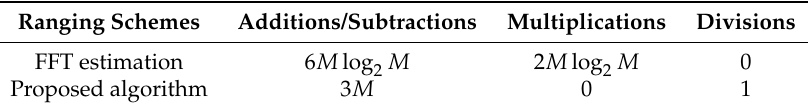
Table 1. Computation complexity for fast Fourier transform (FFT) and proposed time-domain algorithms with M samples.